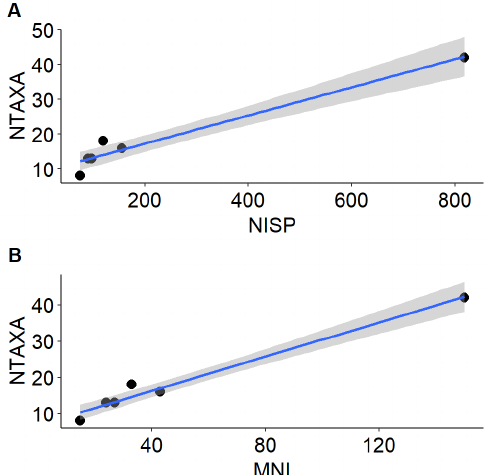
Figure 10. The linear model between taxonomic abundance (NISP and MNI) and taxonomic richness (NTAXA) at Ban Rai Rockshelter (the points represent values per unit in each Area): ( A ) NISP – NTAXA and ( B ) MNI – NTAXA. NISP: the number of identified specimens, MNI: the minimum number of individuals, and NTAXA: the number of taxa identified.